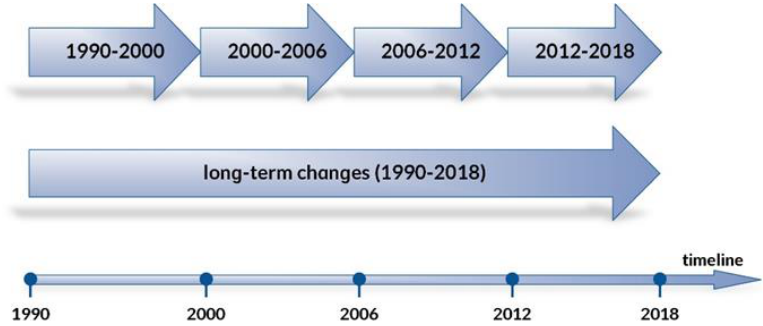
Figure 2. Short and long-term analysis of land cover changes; simplified diagram.